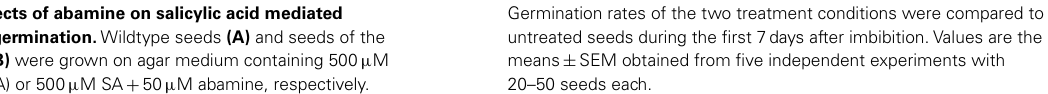
Germination rates of the two treatment conditions were compared to untreated seeds during the first 7days after imbibition.Values are the means ± SEM obtained from five independent experiments with 20–50 seeds